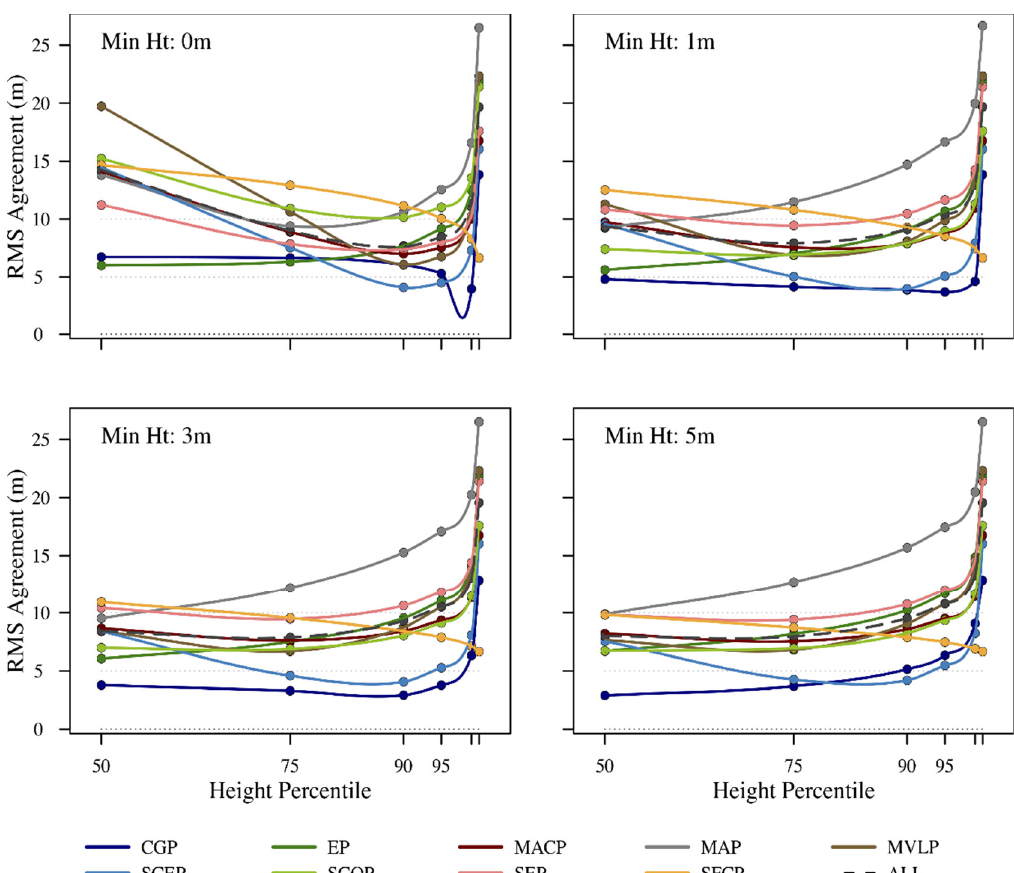
Figure 5. Mean absolute agreement (MAA) statistics by ecoregion (individual spline-fitted lines), height percentiles (horizontal axes), and minimum height categories (panels) computed during the assessment phase of the study. The spline-fits are strictly for visual display.